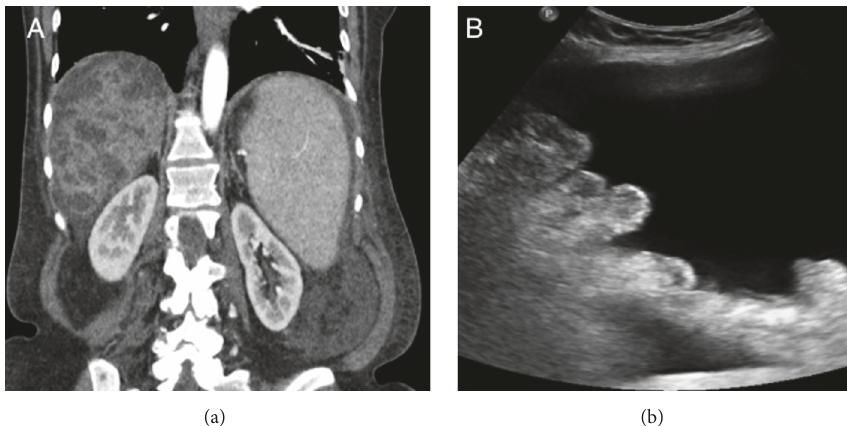
Figure 3: (a) Computed tomography of abdomen and pelvis (coronal view) showing normal architecture and enhancement of bilateral kidneys with no evidence of renal cysts. (b) Abdominal ultrasonographic image showed gross